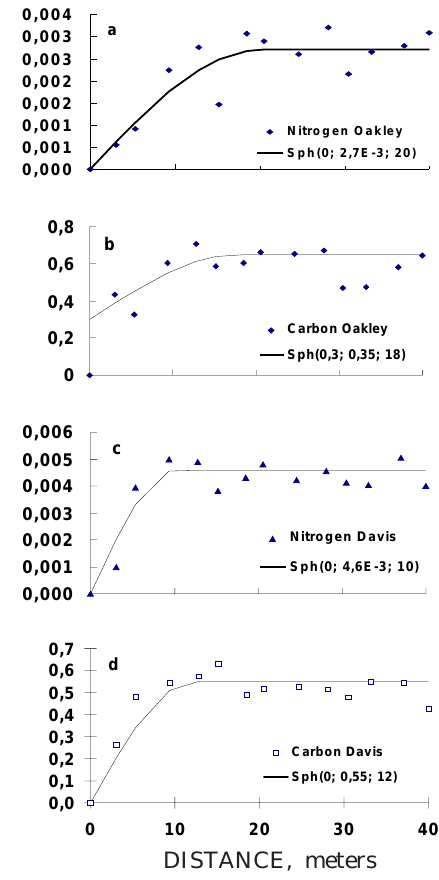
DISTANCE, Figure 4. Individual semivariograms. a) Nitrogen Oakley. b) Carbon Oakley. c) Nitrogen Davis. d) Carbon Davis.